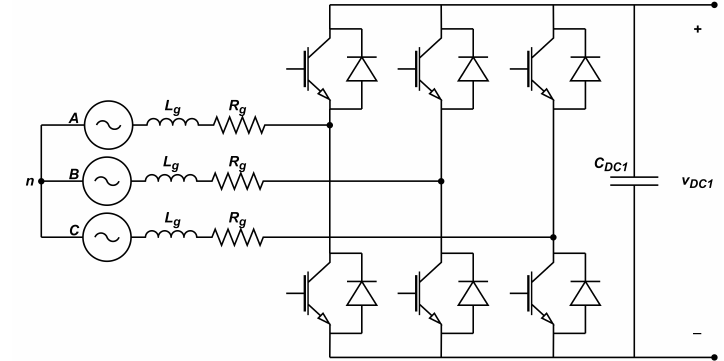
Figure 2. Scheme of the AC–DC converter connected to the